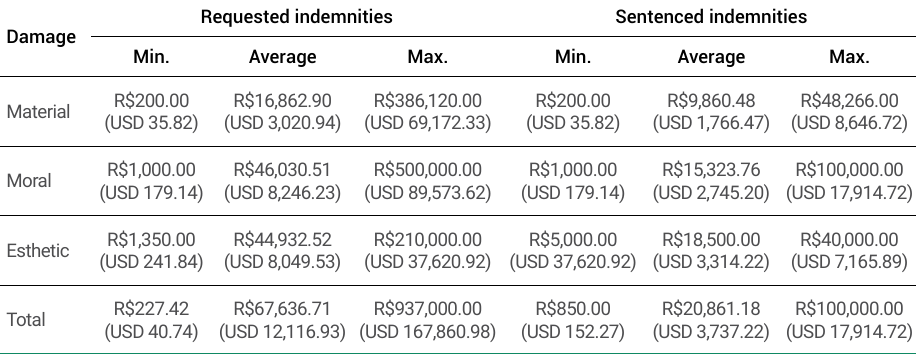
Table 1. Damages requested and sentenced in lawsuits against dentists involving dental malpractice litigance, 2012-2017, São Paulo, SP, Brazil. Requested indemnities Sentenced Damage